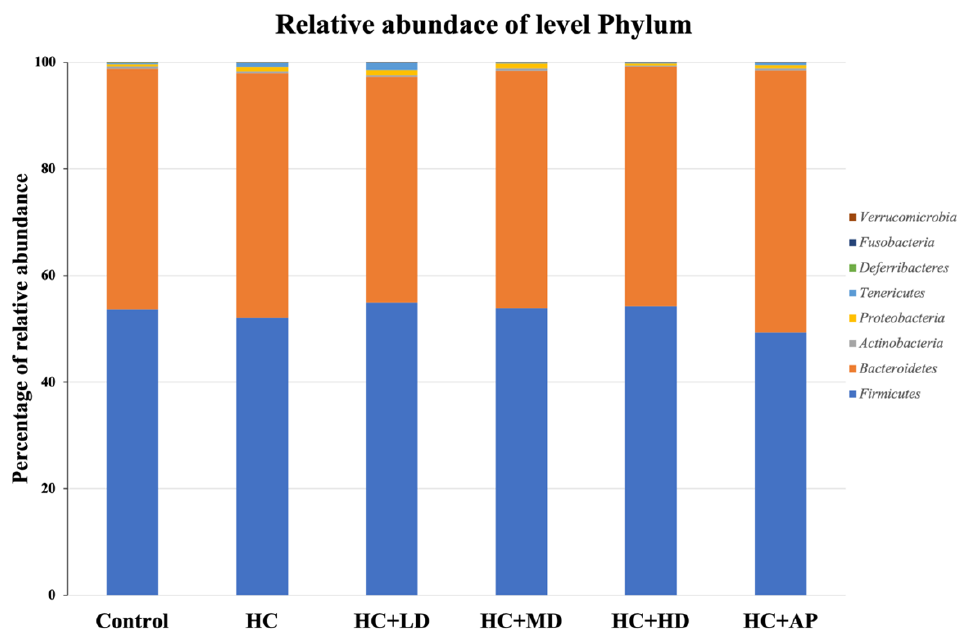
Figure 3. Effect of TCI227 on fecal microbiota phylum-level compositions in PO-induced hyperu- ricemia rats. The reported values are means (n = 3).